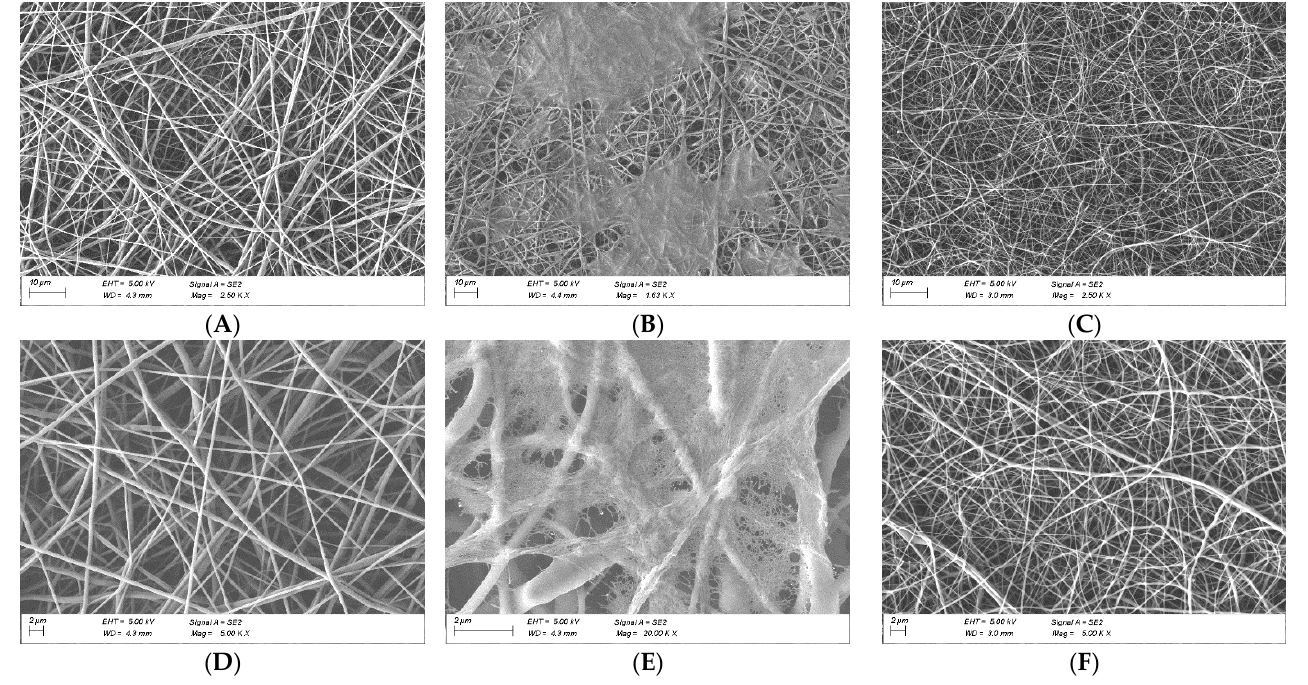
Figure 2. FE-SEM micrographs of electrospun scaffolds: ( A , D ) PCL 10%, ( B , E ) PCL 10% with gelatin coating, ( C , F ) PCL 20%: gelatin 8% (80:20). Scale bar: 10 μ m ( A – C ); 2 μ m ( D – F ). Table 1. Fiber diameter, thickness and pore size measurements of PCL, PCL coated by gelatin and